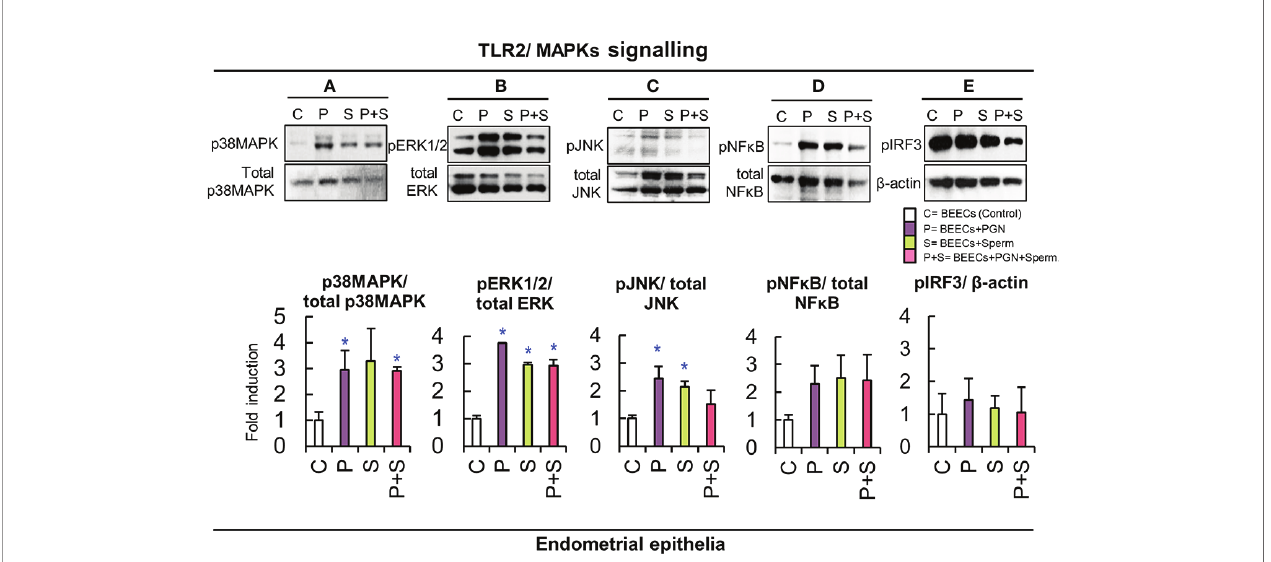
FIGURE 4 | PGN combination perturbed the sperm-triggered JNK phosphorylation in endometrial epithelia. Subcon fl uent BEECs monolayers were exposed to PGN (10 pg ml − 1 ) for 24 h followed by co-culturing with sperm for 1 h. Western blot analysis was carried out to estimate the phosphorylation levels of the mitogen- activated protein kinase (MAPK) cascade components in endometrial cells. Expression of speci fi c antibodies against (A) P38 mitogen-activated protein kinase (p38MAPK), (B) phosphorylated extracellular signal-regulated kinase (pERK1/2), (C) c-Jun N-terminal kinase (JNK), (D) nuclear factor kappa-light-chain-enhancer of activated B cells (NF k B), (E) phospho Interferon Regulatory Factor 3 (pIRF3) was assessed, and b actin was used as a loading control in the different groups. The value under each sample indicates the fold change of the protein level relative to that of the control. The bands ’ intensity was analyzed using a Gel-Pro Analyzer (Media Cybernetics, Rockville, MD, USA). Data are presented as mean ± SEM of 3 independent experiments using epithelial cells from 3 different uteri (3 wells/ treatment/experiment). Asterisks denote a signi fi cant variance (*P<0.05) between the different groups when compared to the control